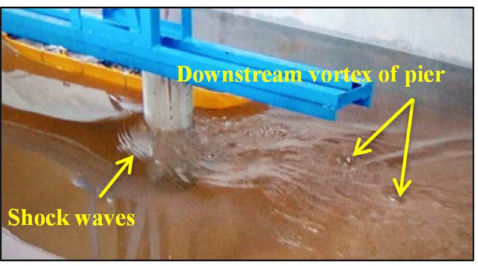
Figure 13. Schematic of a trailing vortex around a pier.